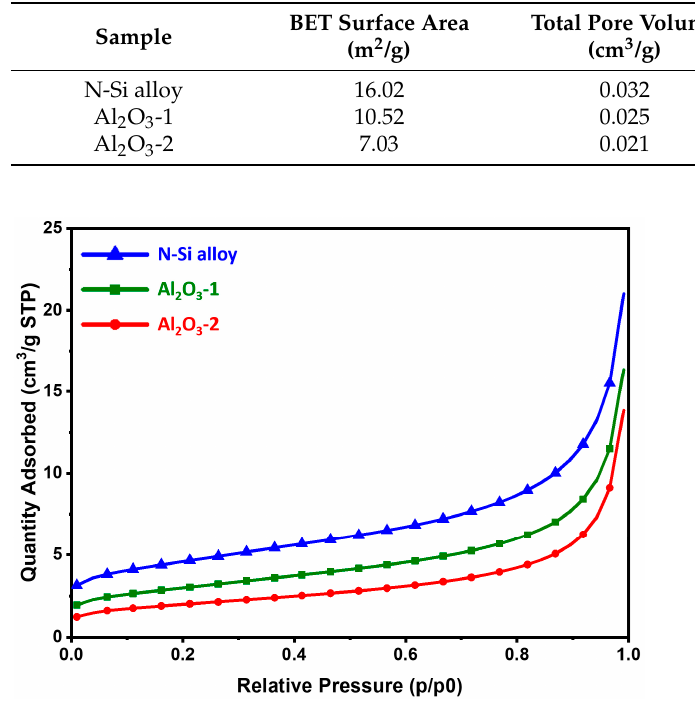
Figure 5. BET adsorption isotherms of the N-Si alloy, Al 2 O 3 -1, and Al 2 O 3 -2 powders.